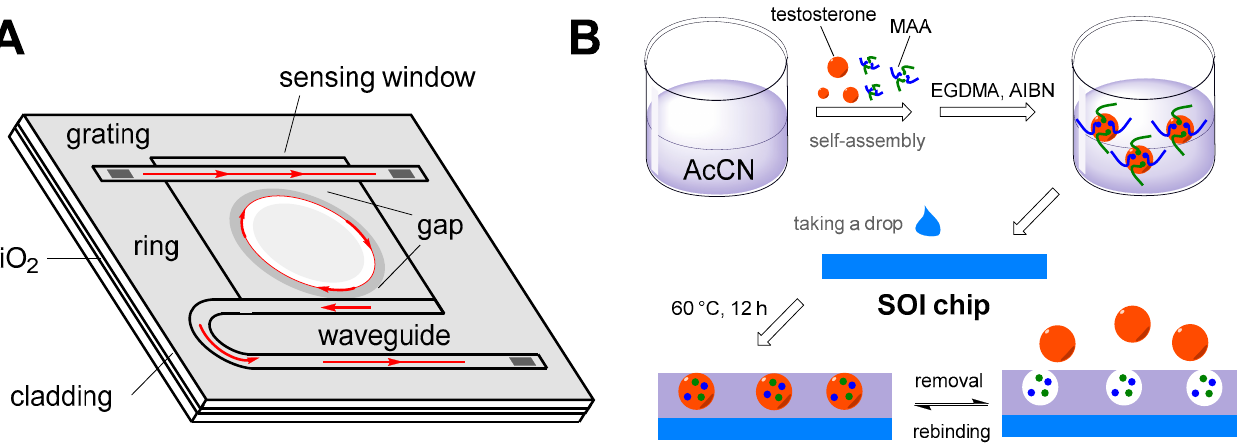
Figure 9. A diagram showing the description of individual parts of a micro-ring resonator sensor ( A ) and the principle of the preparation of molecularly imprinted polymers on the chip surface ( B ); AcCN: acetonitrile, MAA: methacrylic acid, EGDMA: ethylene glycol dimethacrylate, AIBN: 2,2 ′ - azobis(2-methylpropionitrile), SOI: silicon-on-insulator wafer) [135].